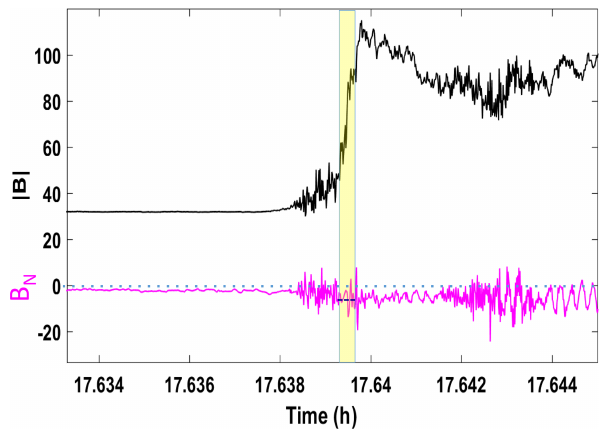
Figure 5. Time variation of the B amplitude and of its associated B n normal component (used to verify the criterion on the normal com- ponent; see Sect. 2.2) on 31 March 2001 around 17:38UT, where = 86 ◦ ± 2 ◦ , and β i = 0 . 04; time is in decimal hour. M A = 4 . 1, θ B n The vertical yellow bar indicates the identified location of the